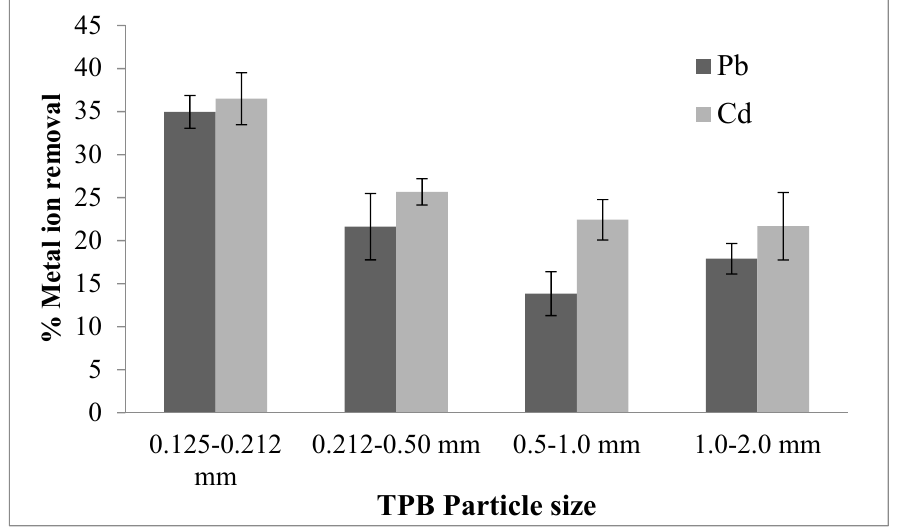
Figure 7. Effect of particle size (0.10 g) on metal ion removal (mean ± RSD) (50 mL, 50 ppm, pH 4) (120 rpm, 60 min, 25 °C). Each measurement has been done in triplicate.